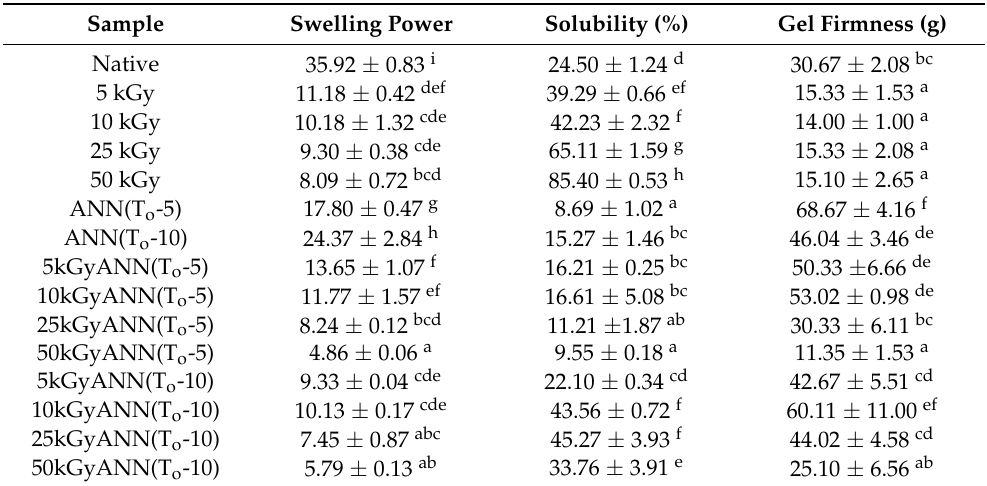
Table 2. The swelling power and solubility (in excess water at 85 ◦ C) and gel firmness for native and modified sago